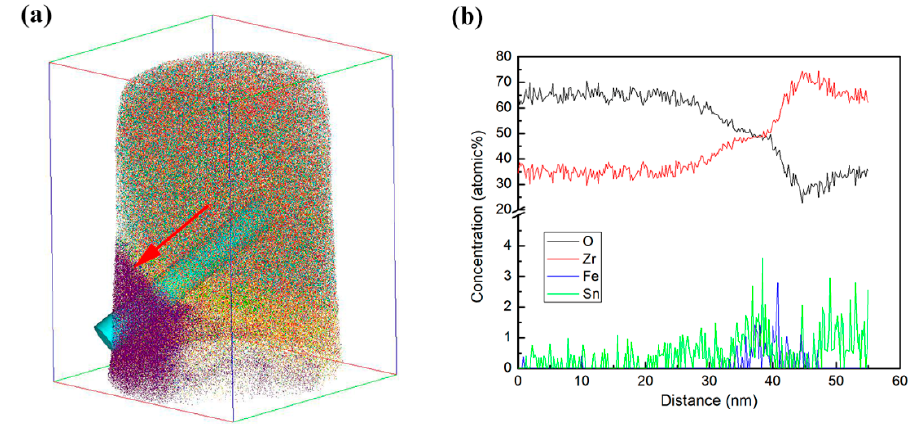
Figure 6. The distribution of ZrO 2 ( red ), ZrO ( yellow ), Zr ( purple ), Fe ( blue ) and Sn ( green ) in the needle-shaped specimen prepared in the oxide covered on the S N surface of the Zircaloy-4 specimen corroded in lithiated water with 0.01 M LiOH at 633 K/18.6 MPa for 70 d exposure. The specimen was around the O/M interface. The size of the maps showing the atom distribution was 73 × 71 × 98 nm 3 .